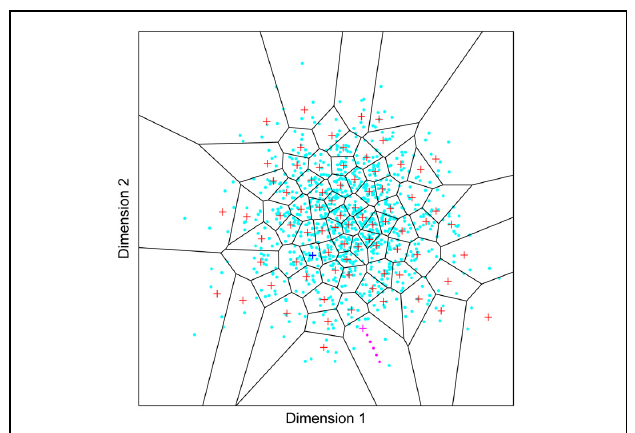
FIGURE A1 | Outcome of a self-organizing system exposed to 500 face images. The light blue dots represent the projection of the 500 faces into two arbitrary dimensions of face space. If an individual’s face contains a feature which activates the classifier “ + ” highlighted in pink, then caricaturing (in this case increasing along Dimension 1 and decreasing along Dimension 2) will form an effective caricature. Caricaturing can be thought of as shifting the face along the trajectory of pink dots. Note that even at large distances from the point corresponding to the classifier’s weight vector (pink “ + ”), such images can be effective stimuli for the classifier because it experiences reduced inhibition from its neighboring neurons. If the face activates the classifier indicated in dark blue, neither dimension offers good scope for caricaturing. Hence a caricature artist would do well to choose an alternative dimension, of which there will be